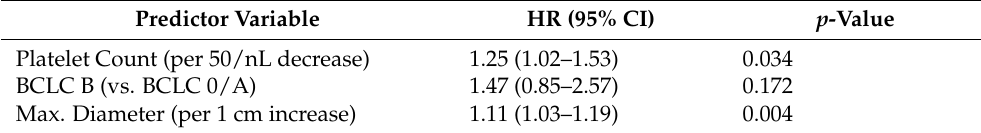
Table A2. Overall survival analysed by multiple Cox regression (plt count: continuous variable).